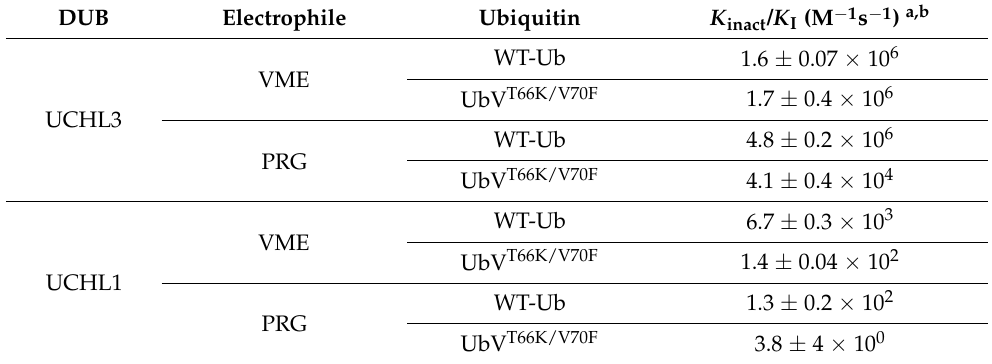
Table 1. Inactivation efficiency for WT- and double mutant UbV-ABPs versus UCHL3 and